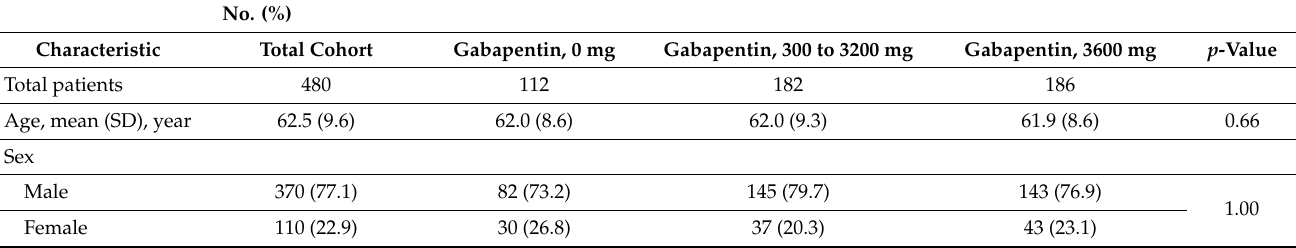
Table 1. Clinical characteristics of the overall